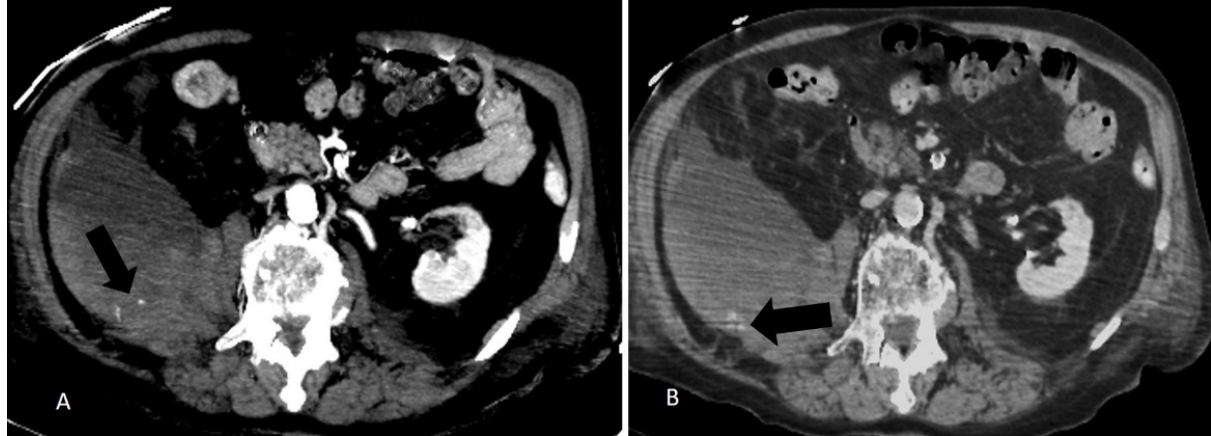
Figure 3. ( A ) Arterial phase CT and ( B ) late phase CT of a right retroperitoneal and ileo-psoas hematoma. Note multiple arterial intralesional blushes (arrow in A ) show a contrast late enhancement (arrow in B ).